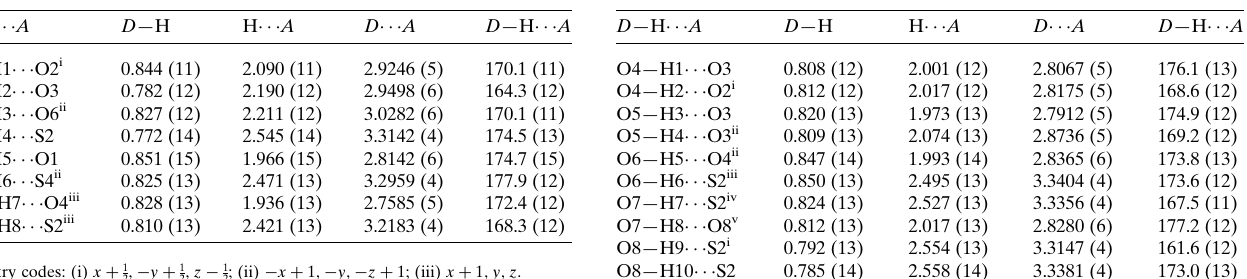
Table 2 Hydrogen-bond geometry (A˚ , (cid:3) ) for Na 2 S 2 O 3 (cid:2) 5H 2 O at 100 K.